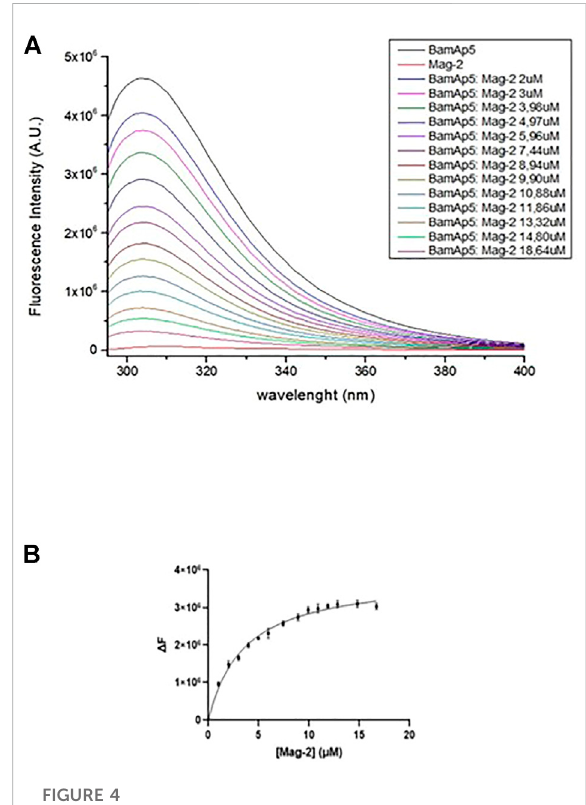
FIGURE 4 (A) Intrinsic fl uorescence spectra ( λ exc = 280 nm) of 3.7 × 10 − 6 M BamA p5 by adding different concentration of Mag-2 every 5 min at 20 ° C. (B) Binding of Mag-2 to BamA p5 as determined by